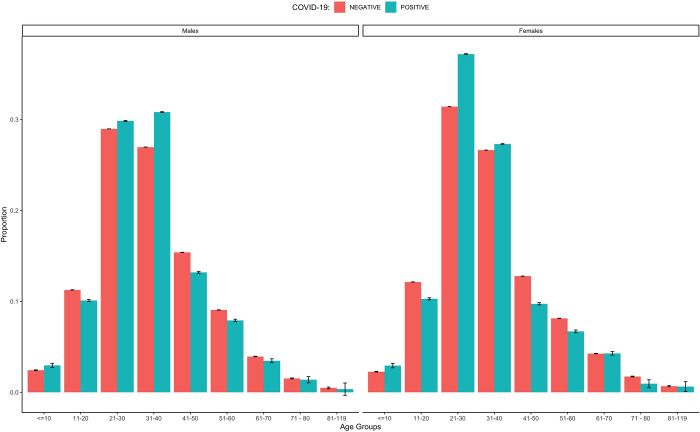
Age distribution of SARS-CoV-2 infections.